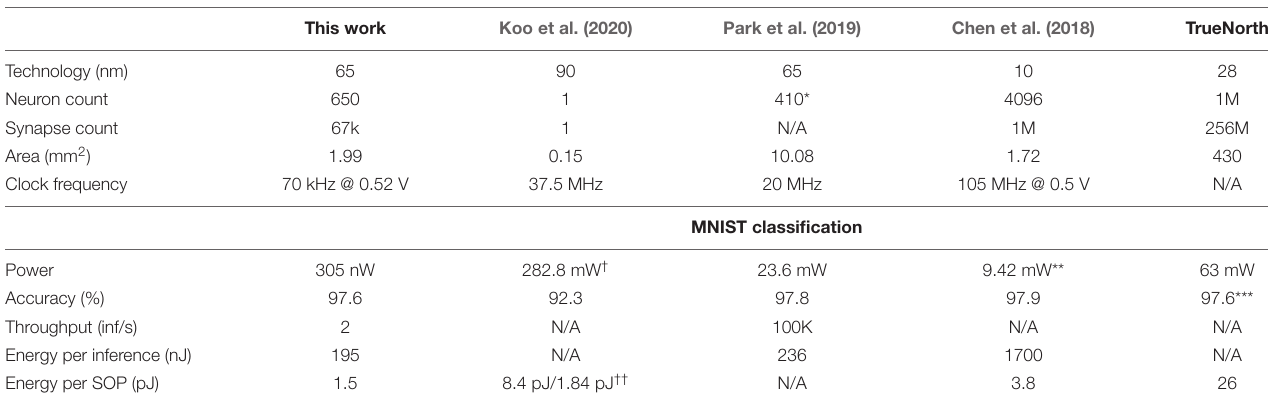
TABLE 2 | Comparisons with recent SNN